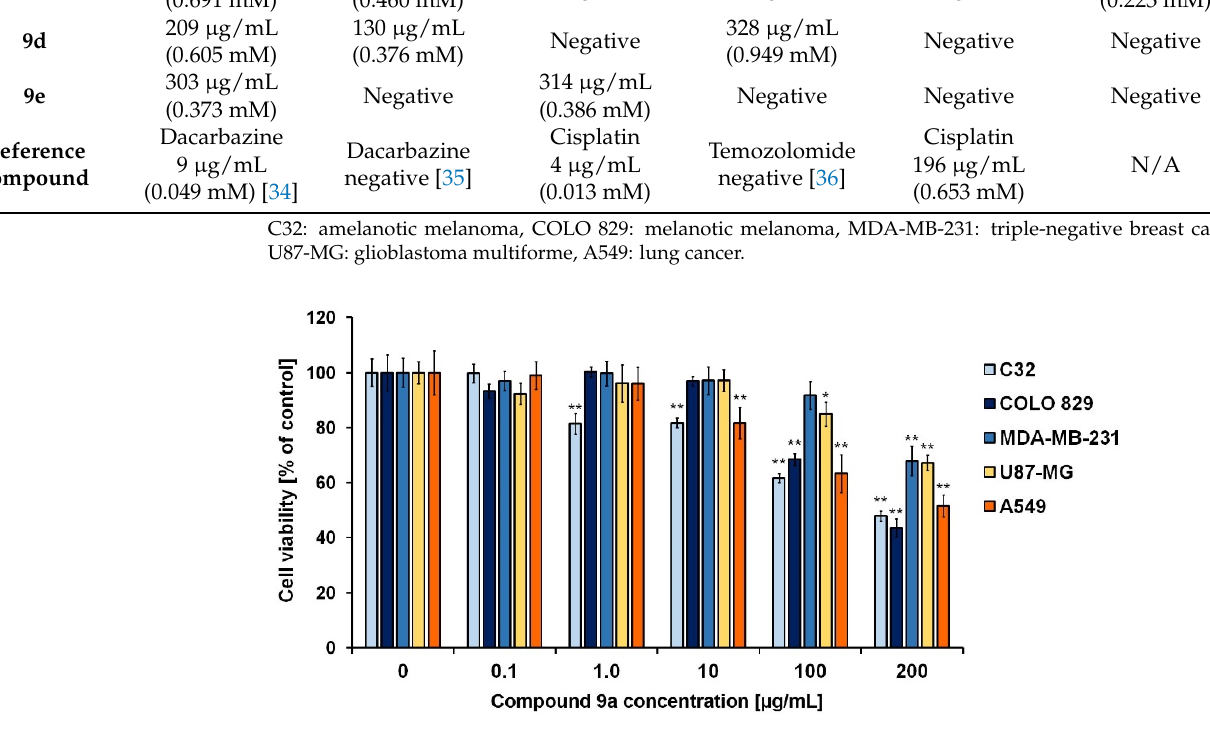
Table 2. The anticancer potential of synthesized compounds 9a – e expressed as GI50, i.e., the concen- tration inhibiting cell growth by 50% as compared with control cells.